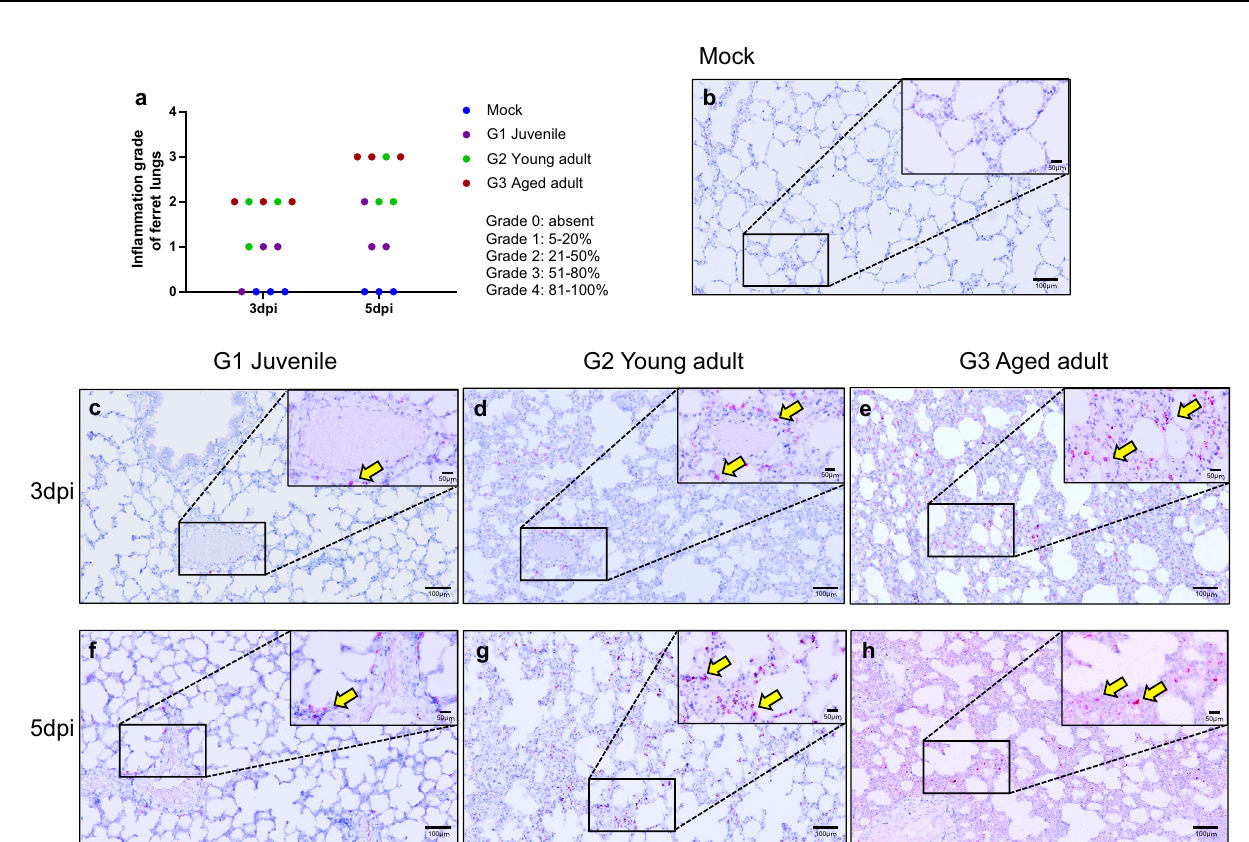
Fig. 3 RNAscope in situ hybridization in the lung of SARS-CoV-2 infected ferrets. To detect the SARS-CoV-2 RNA (Spike gene) in lung tissues, RNAscope in situ hybridization was performed using a Spike-speci fi c probe and visualized using RNAscope 2.5 HD Reagent Kit RED. The degree of in fl ammation in lung tissues was scored as Grade 0 – 4 based on the estimated percentage of the lung tissue slides affected by lesions ( n = 6/group) ( a ). SARS-CoV-2 spike RNA-positive cells (Yellow arrows) in lung tissues of mock infected ( b ), juvenile ferrets ( ≤ 6 months, G1 group) ( c and f ), young adult (1 ≤ age ≤ 2 years, G2 group) ( d and g ), and aged ferrets (3-year ≤ ages) ( e and h ). Lung sections of different age groups at 3 dpi ( n = 3/group) ( c , d , and e ) and at 5 dpi ( n = 3/group) ( f , g , and h ). Magni fi cation is 100x and scale bar represents 100 μ m. Insert indicates the magni fi ed (200x) of SARS-CoV-2- positive and scale bar represents 50 μ